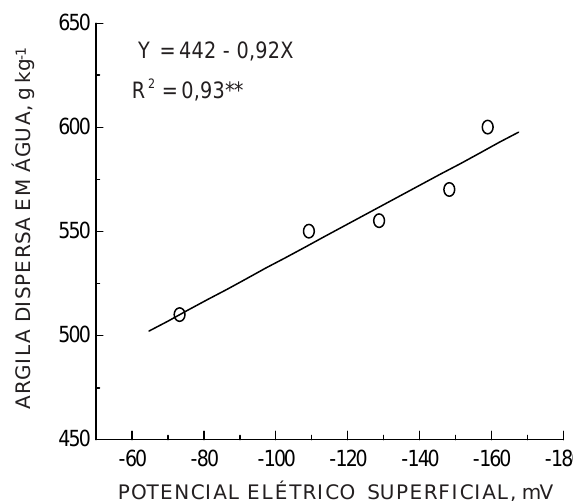
Figura 4. Relação entre o potencial elétrico superficial e a argila dispersa em água em um Latossolo Bruno submetido a doses crescentes de calcário.** Significativo a